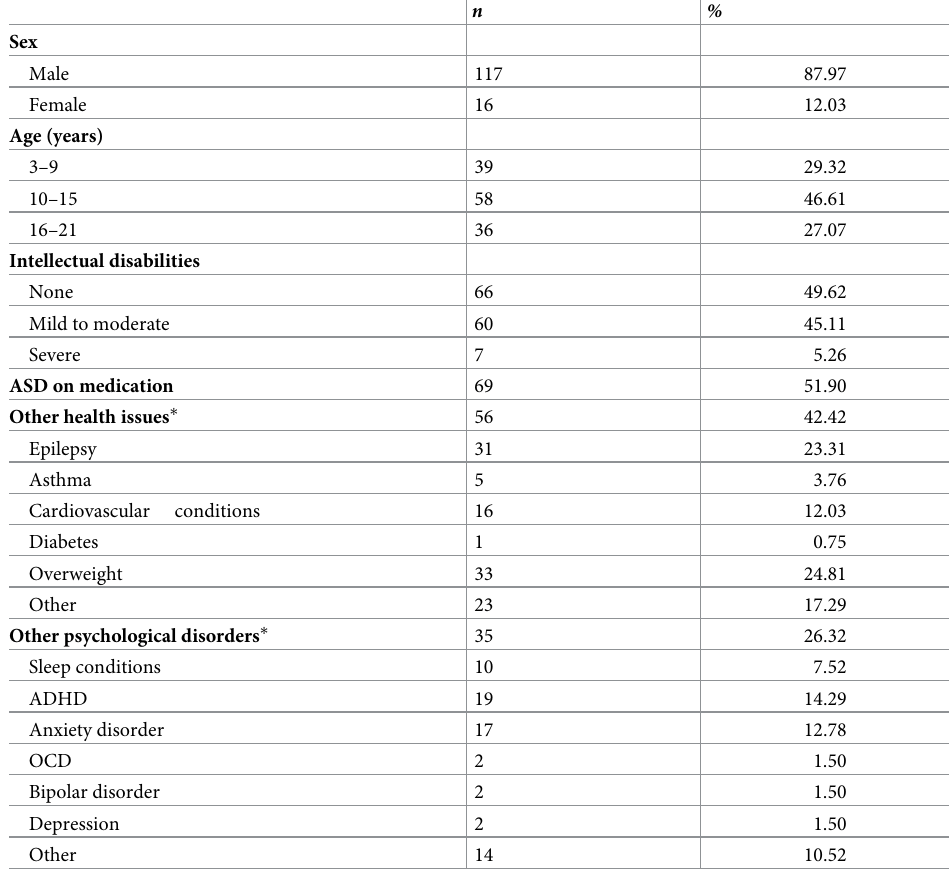
Table 1. Study participant demographic characteristics and clinical information ( N =